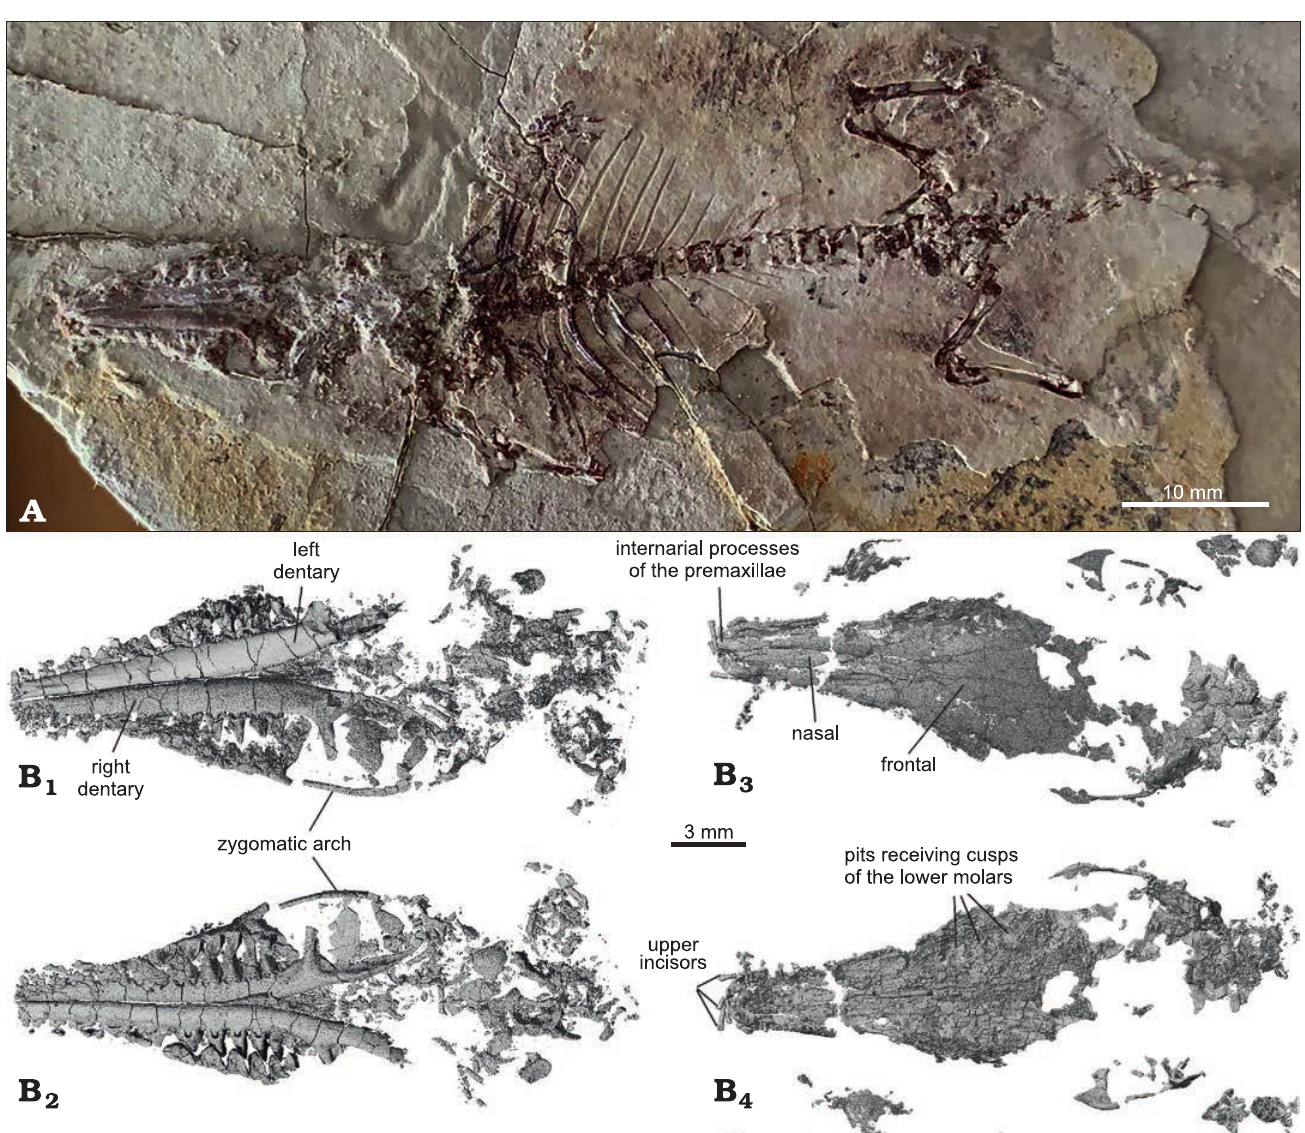
Fig. 1. New specimen of Lactodens sheni Han and Meng, 2016 (ZGY0053) from Aptian, Lower Cretaceous Jiufotang Formation of Dapingfang, Caoyang City, Liaoning Province, China. A . Partial skeleton in dorsal view that is preserved in the main slab. B . CT rendered partial skull; mostly ventral portion with teeth in dorsal (B 1 ) and ventral (B 2 ) views and mainly the skull roof in dorsal (B 3 ) and ventral (B 4 )